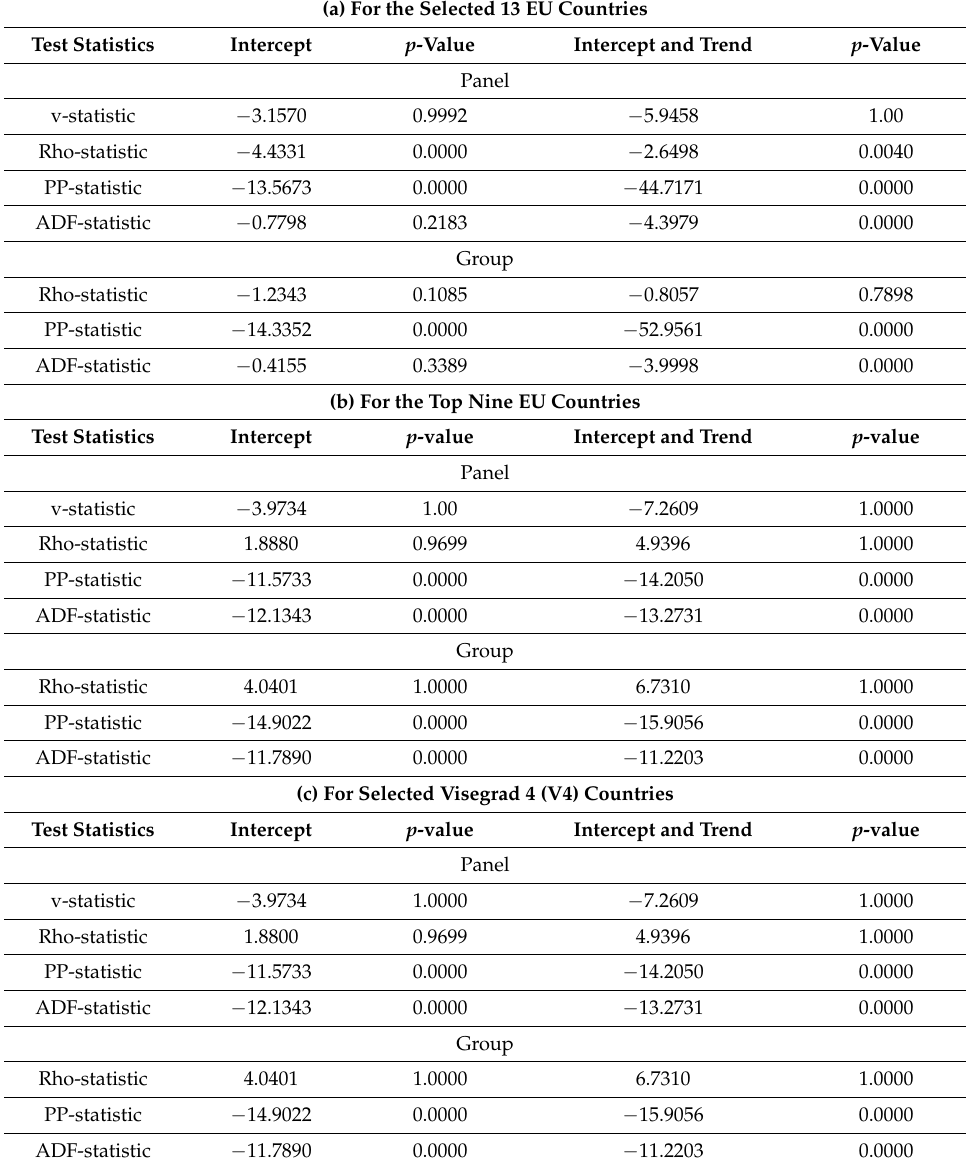
Table 6. The results of Pedroni Cointegration